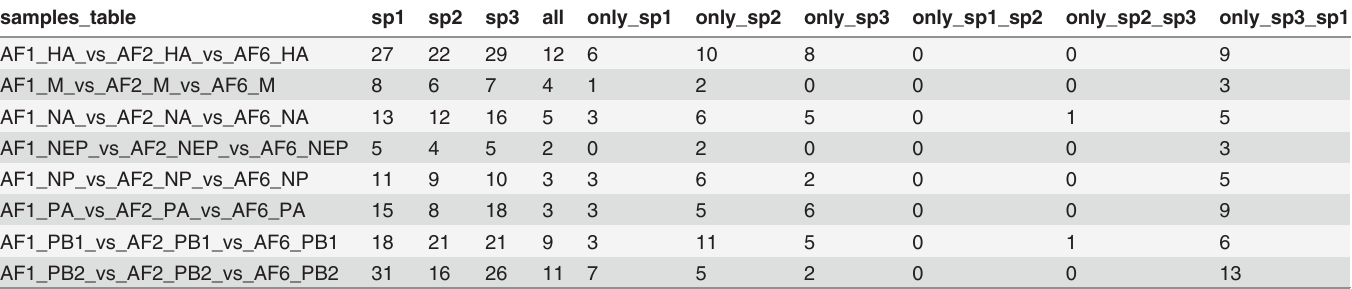
Table 4. The outputs of SNPer for the eight fragments of the three different IFVs ( “ summary.csv ”